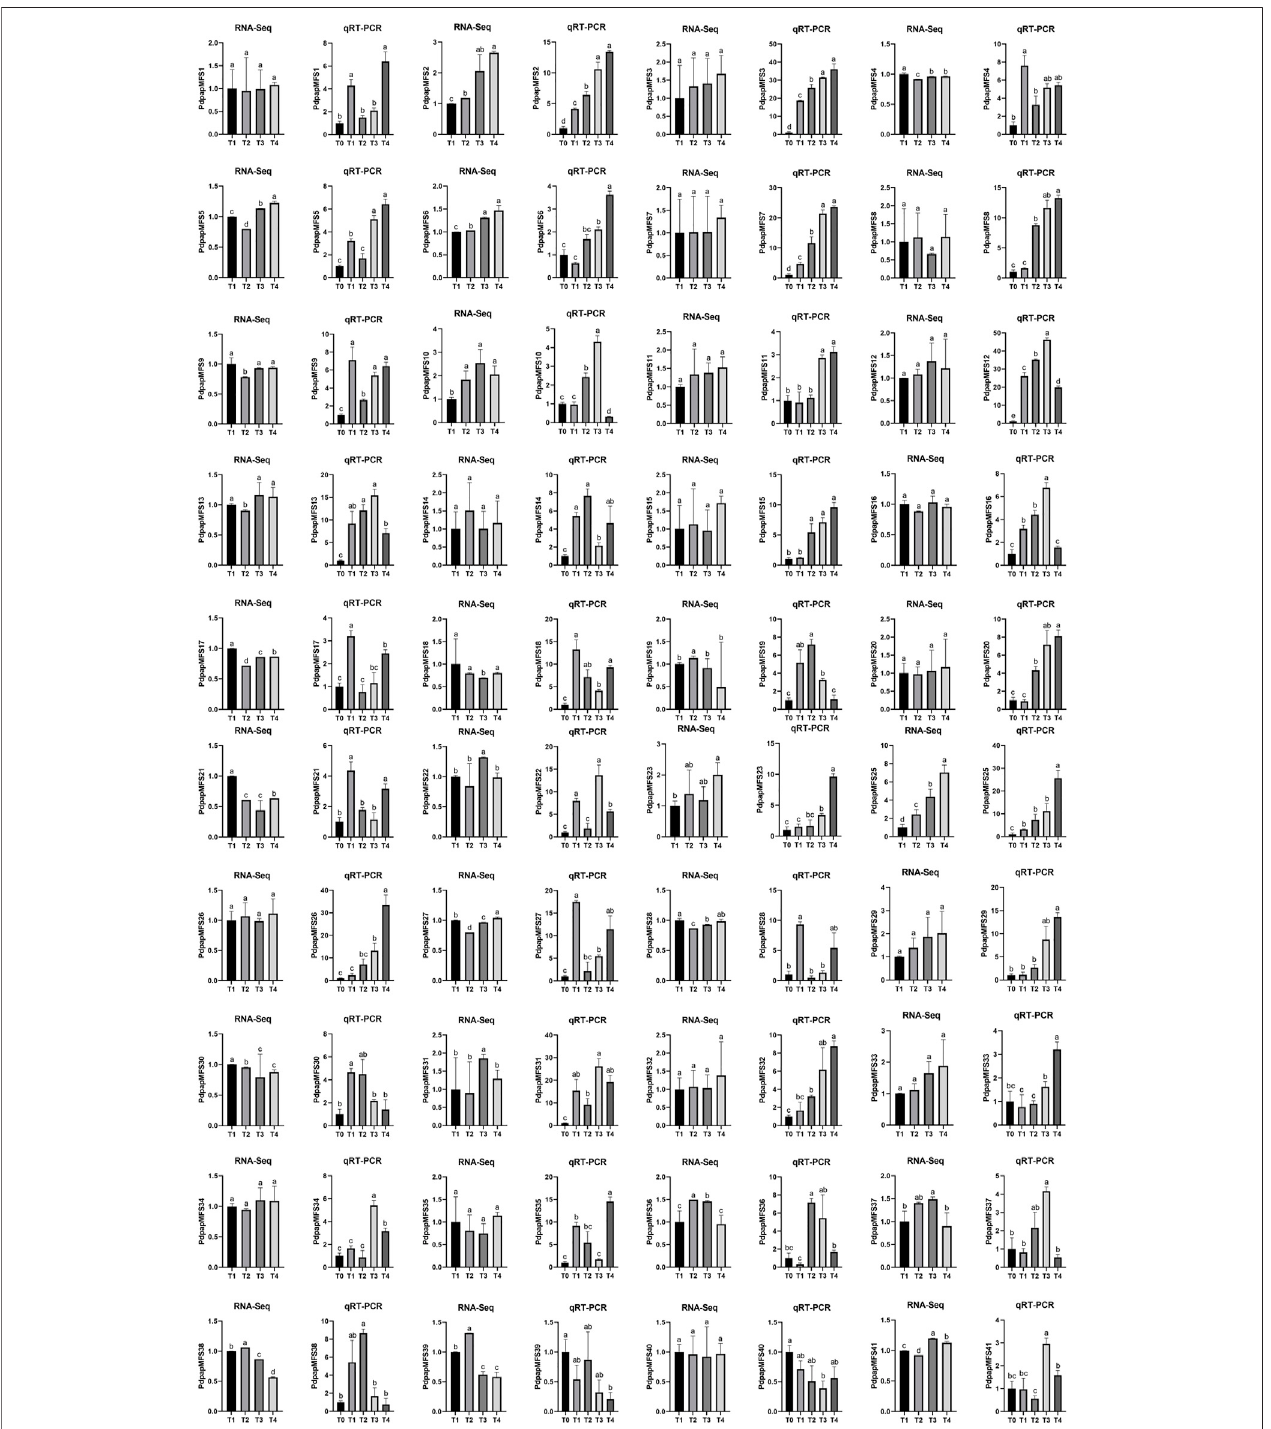
FIGURE 11 | DEG expression levels in Pdpap based on RNA-Seq and qRT-PCR. Expression levels in RNA-Seq was quanti fi ed by fragments per kilo-bases per million mapped reads (FPKM). T0, T1, T2, T3, and T4 indicated that PdPap were infected by F. oxysporum for 0, 6, 12, 24, and 48 h. Error bars represented standard deviationofthreeindependentreplicates.Signi fi cantdifferences( p < 0.05)wereindicatedbydifferentlowercaseletters.Geneco-expressionandgeneontologyanalysis.